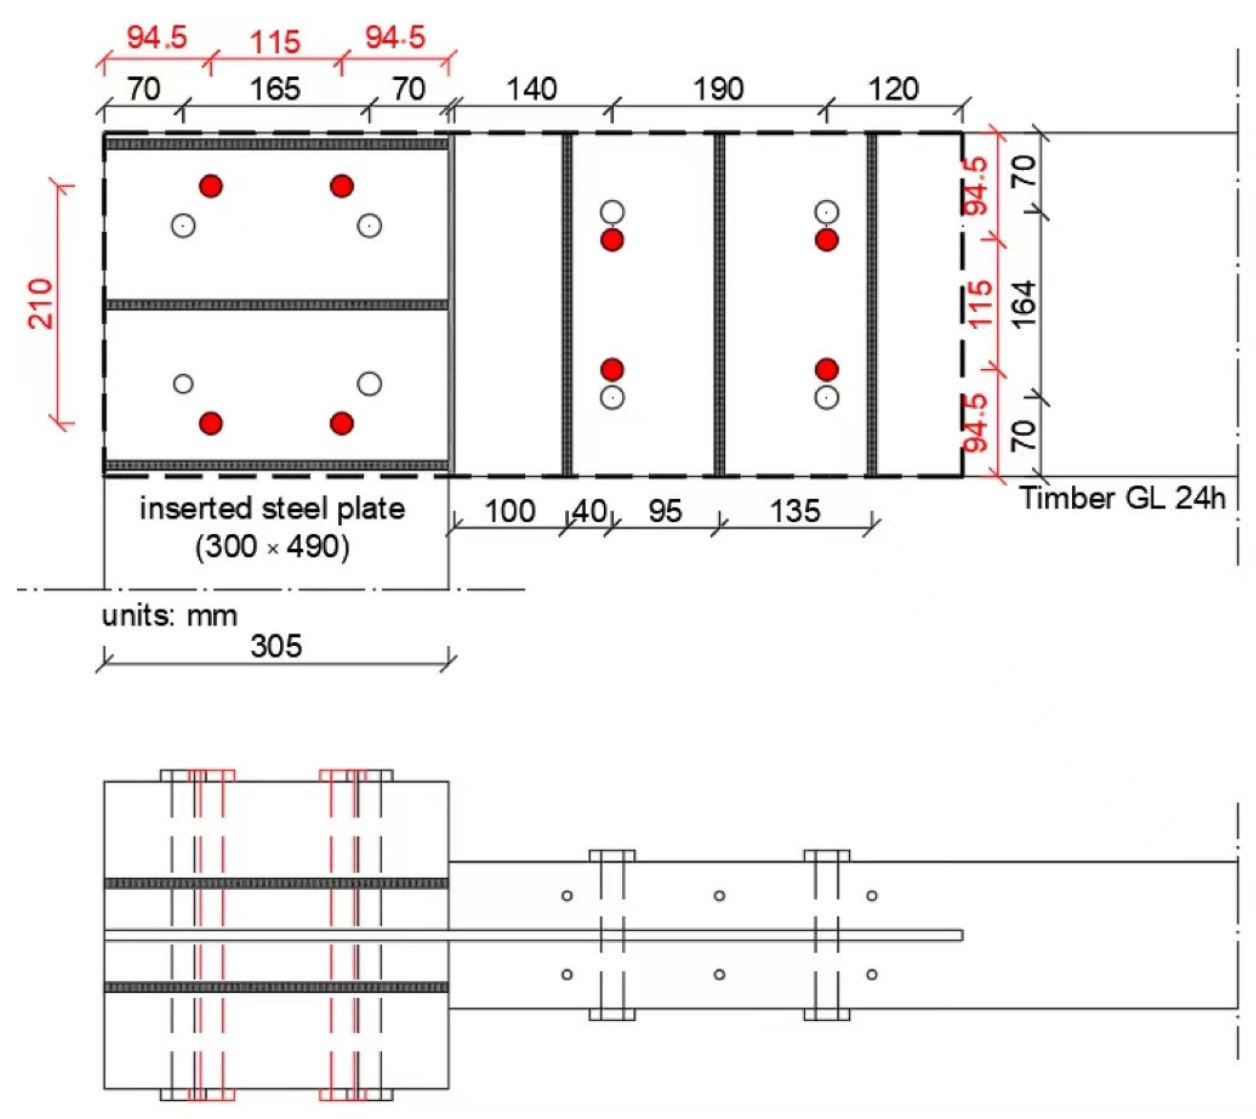
Figure 14. Summary of main geometries used in ductile moment-resisting